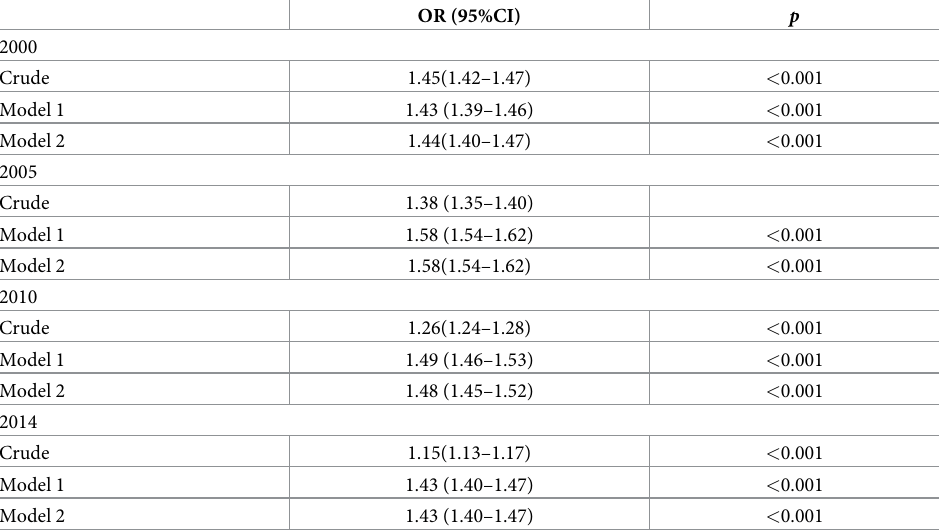
Table 3. The associations between relative HS (continuous variable) and hypertension (per IQR